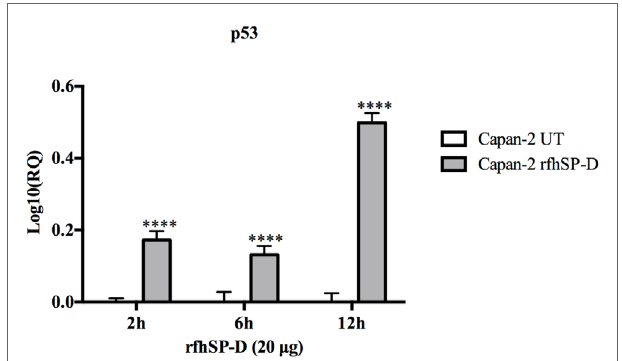
FigUre 6 | Relative quantification (RQ) of p53 mRNA expression in Capan-2 cell line treated with rfhSP-D (20 µg/ml) for 2, 6, and 12 h. p53 expression was significantly upregulated in the rfhSP-D-treated samples at 2, 6, and 12 h as compared to the untreated. Significance was determined using the unpaired two-way ANOVA test (**** p < 0.0001) ( n =